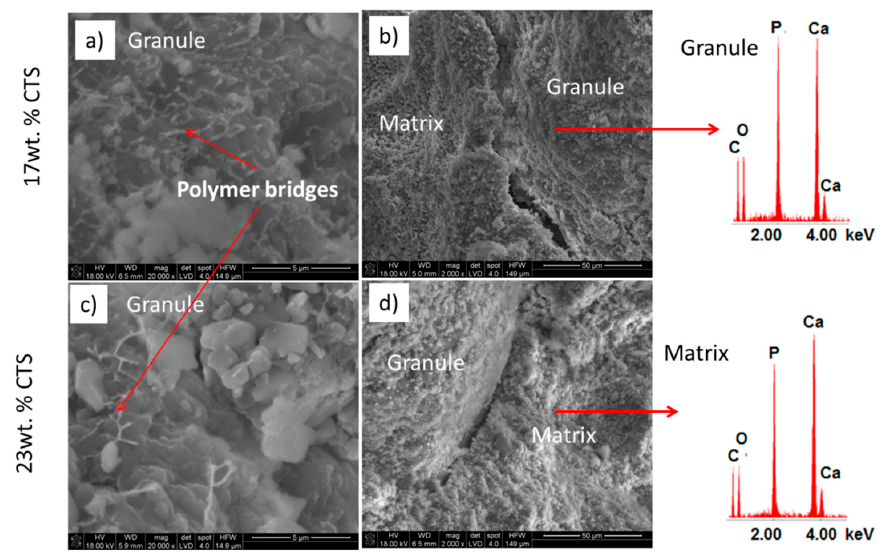
Figure 4. SEM microphotographs of cross-sections of materials from Series A ( a , b ) and B ( c , d ), and results of EDS analysis.